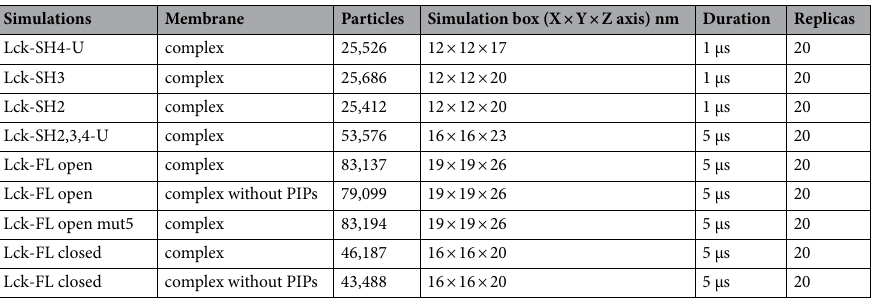
Table 1. Summary of CGMD simulations conducted in this study. (Symmetric) membrane composition: complex: POPC/POPE/POPS/Chol/PIP 2 /PIP 3 = 12/40/20/20/6/2; complex without PIPs: POPC/POPE/POPS/ Chol =